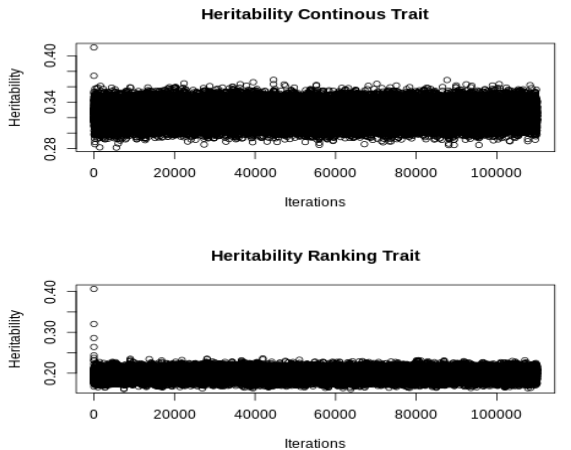
Figure 1. Plot of the Gibbs sampler iterations of the heritabilities of the continuous and ranking traits.